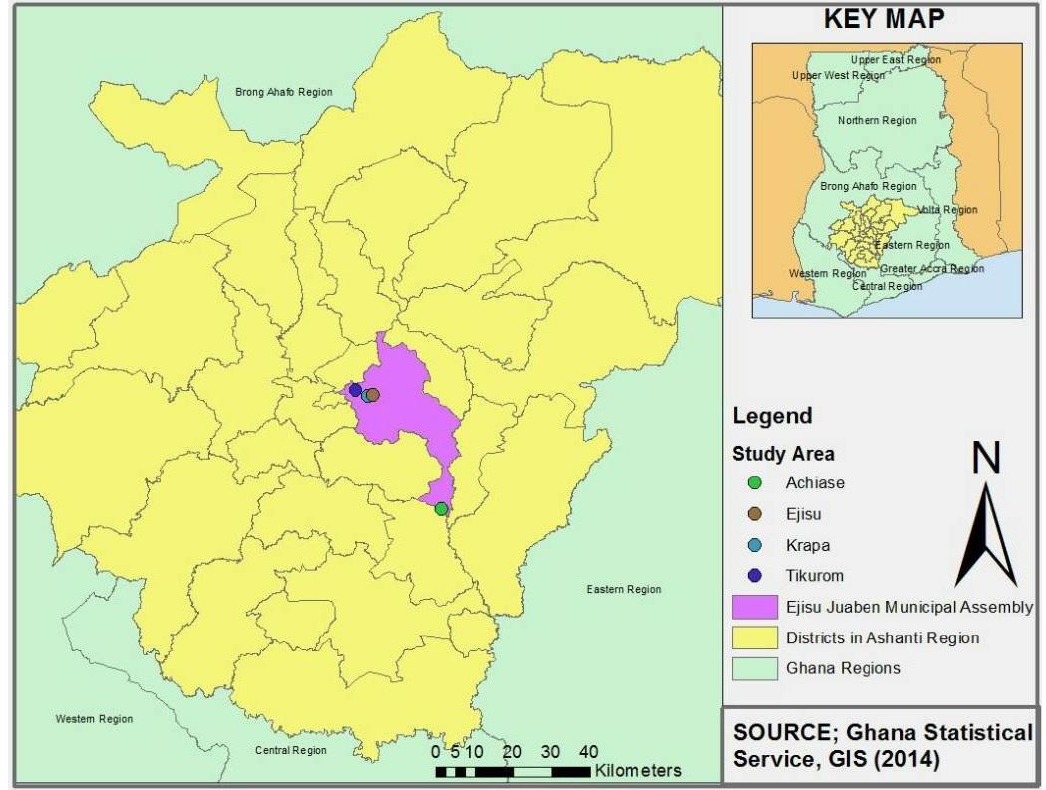
Fig. 1. Study Communities in the Ejisu-Juaben Municipality,